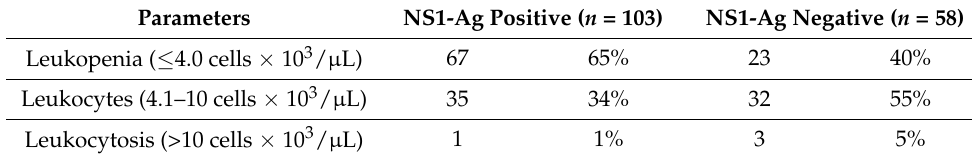
Table 6. Comparison of leukocytes count by DENV NS1-Ag test